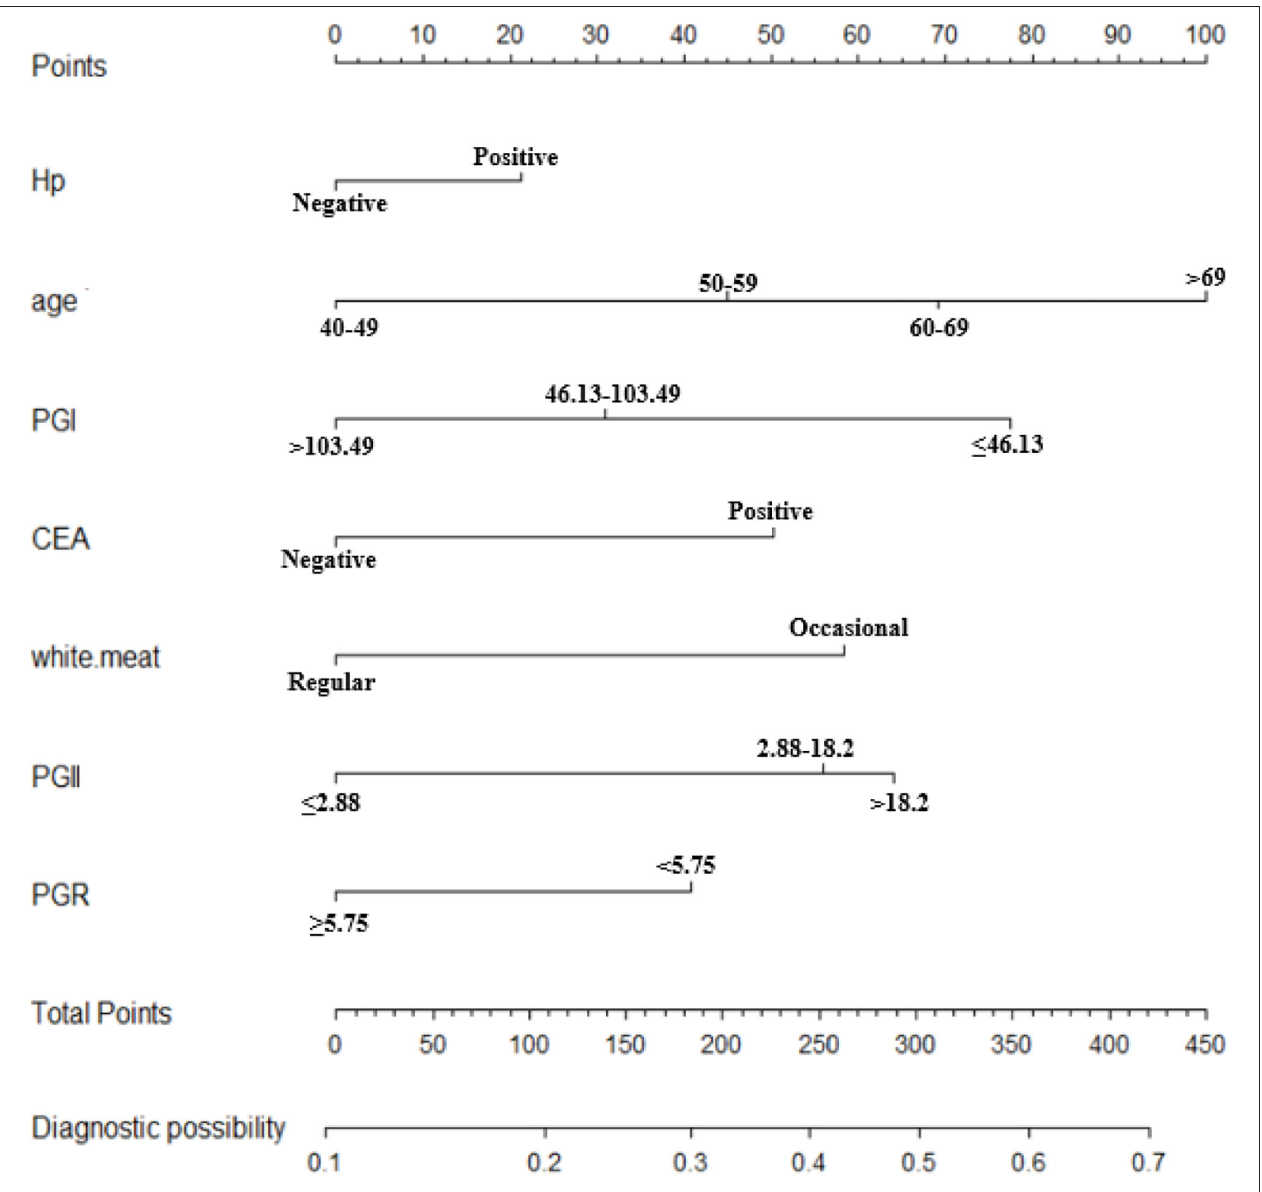
FIGURE 2 | Nomogram to predict the probability of OLGA any-stage in the Chinese high-risk gastric cancer population. *For the variables of eating habits (white.meat), two types of consumption frequency were provided, namely, occasional ( < 3 times a week) and regular (at least three times a week). OLGA, operative link for gastritis assessment; Hp, Helicobacter pylori ; CEA, carcinoembryonic antigen; PG, pepsinogen; PGR, PG I/II